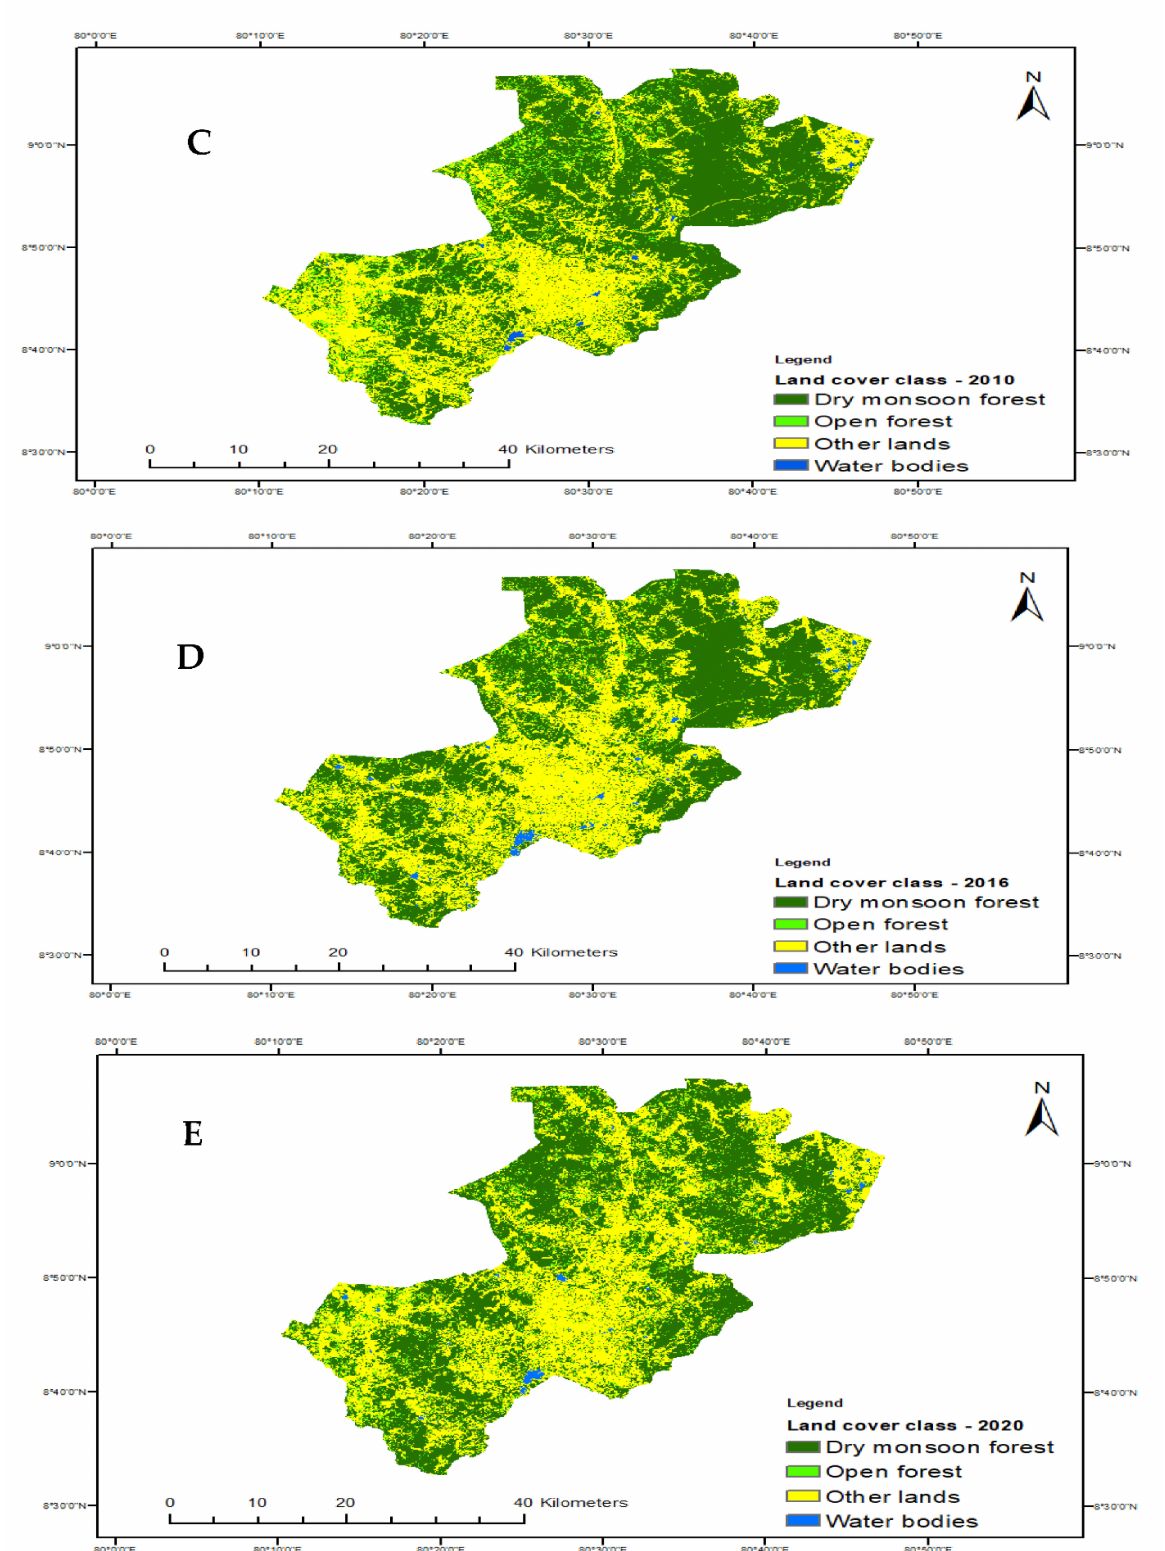
Figure 3. Land cover maps of Vavuniya District, Sri Lanka, in 2001 ( A ), 2006 ( B ), 2010 ( C ), 2016 ( D ), and 2020 ( E